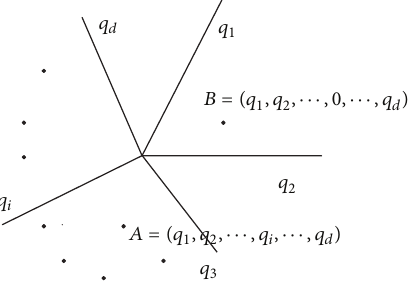
Figure 3: Data space 𝑄 with 𝑑 - dimension